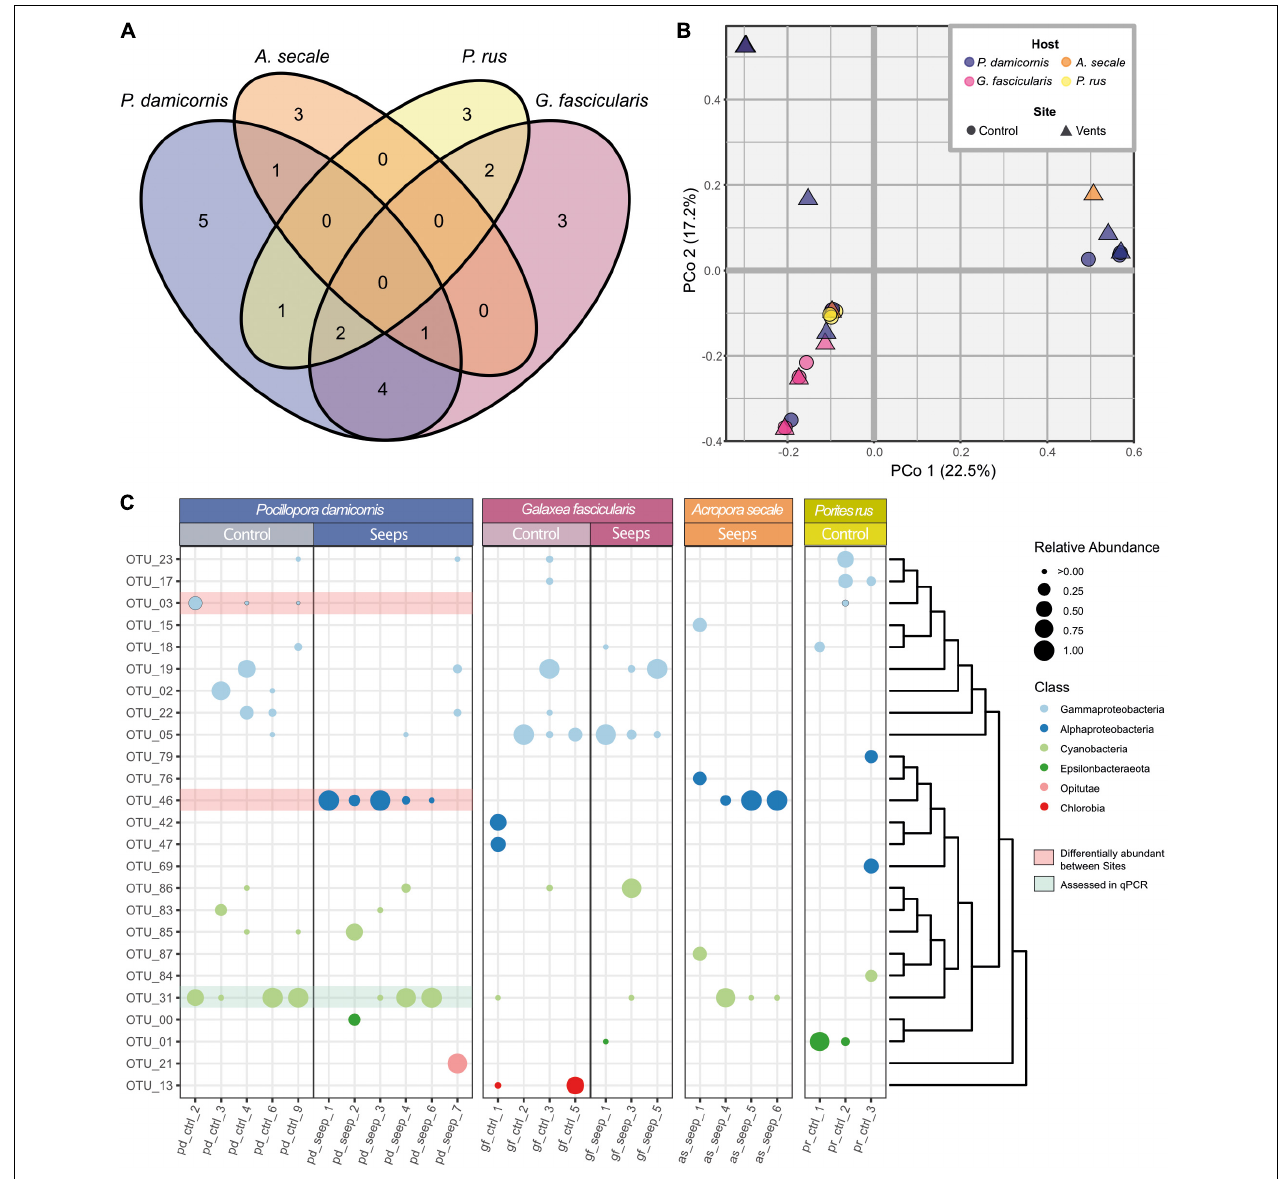
FIGURE 3 | Diazotroph community composition of coral hosts from a high p CO 2 and an ambient p CO 2 site (A) Venn diagram showing number of observed OTUs and their distribution across the four examined coral species. (B) Principal coordinate analysis of Bray-Curtis distance matrix for all 25 coral samples with ≥ 100 sequences from the 25 cluster I-III nifH representative OTUs. First two principal coordinates are shown, explained variance in parentheses. (C) Relative abundances of OTUs per sample. OTUs are sorted according to their phylogenetic relationship as indicated by the dendrogram to the right. Class level phylogenetic association is shown in different dot colors. Red highlighted OTUs are differentially abundant between P. damicornis samples from the control and seeps site according to LEfSe analyses. OTU_31 (highlighted in green) was used for relative gene copy abundance estimates using qPCR.